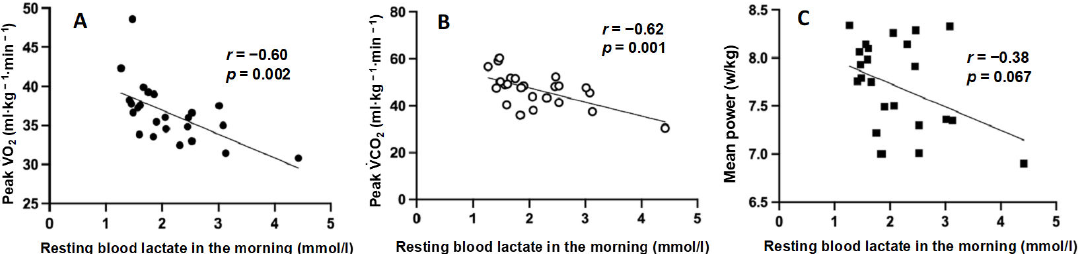
Figure 6. Relationship between resting blood lactate in the morning and peak VO 2 ( A ), peak VCO 2 ( B ), mean power ( C ) during 40 s Wingate test. The dots represent the average values for the subjects during one week in each